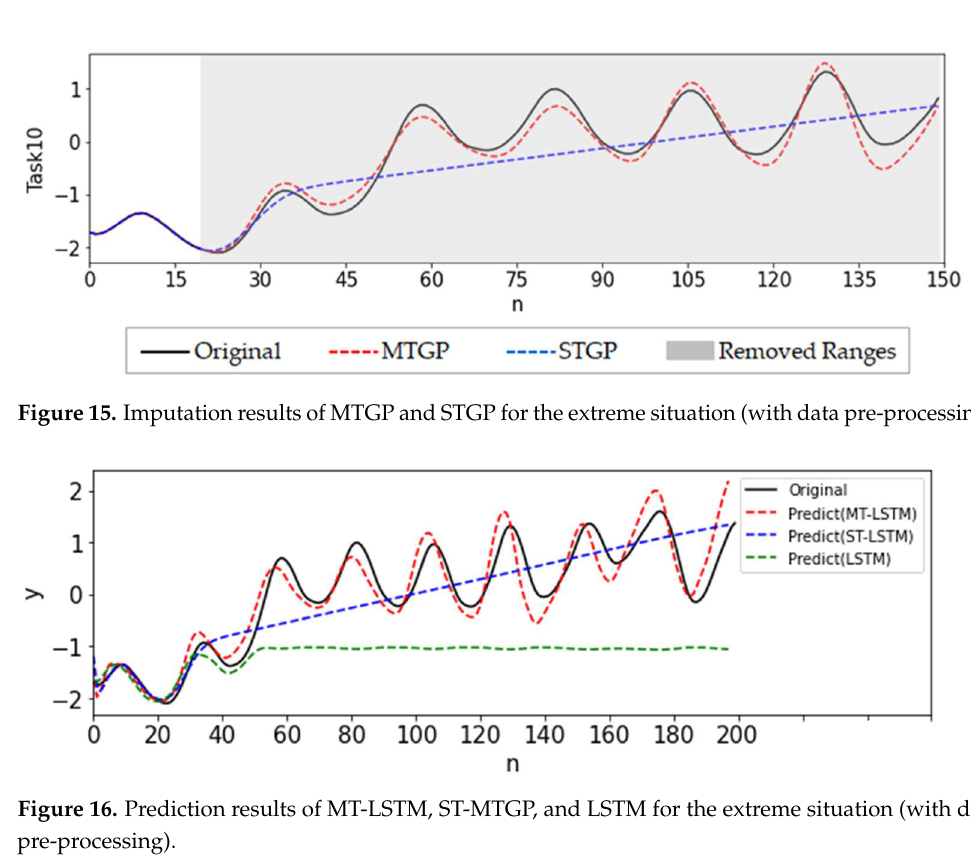
Figure 14. The first 5 principal components after data pre-processing from the compressor data.